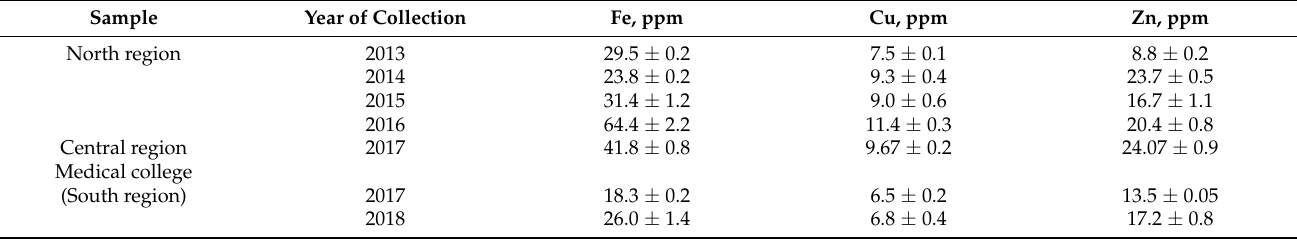
Table 1. Microelement content of different Ginkgo biloba seed samples. The results are mean of four scans ± standard deviation (SD).